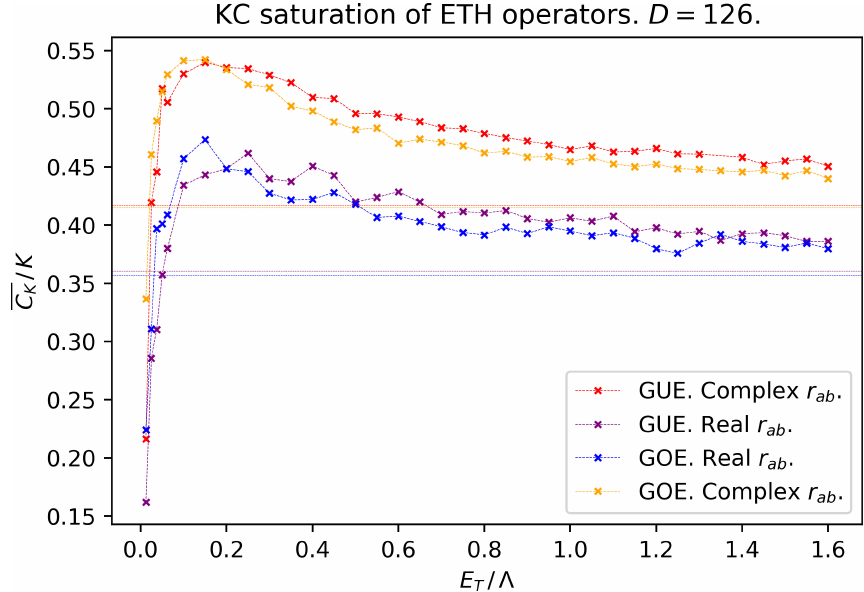
Figure 8. K-complexity saturation value as a function of the Thouless energy for different ETH operators (either real or complex in the energy basis) with Hamiltonians drawn from two different RMT ensembles (GOE and GUE). The horizontal lines mark the asymptotic value for E corresponding to the case of observables satisfying the pure RMT operator Ansatz. In order to mod out system-dependent scaling of the energy spectrum due to the choice of normalization of the Hamiltonian, the Thouless energy was normalized by the total bandwith Λ , allowing for potential comparisons with other